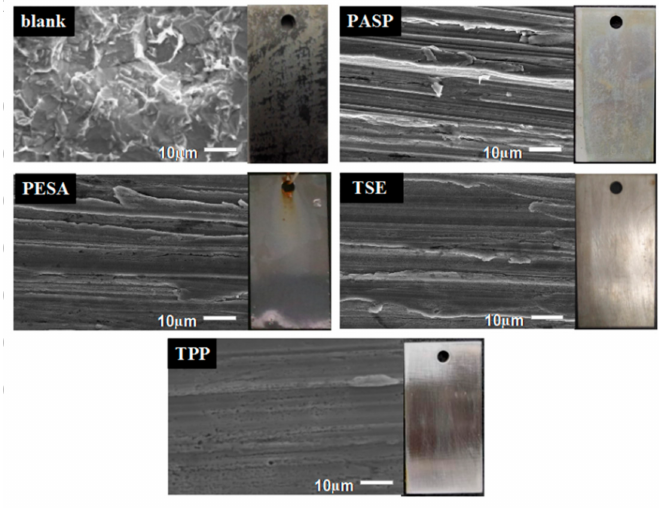
Figure 4. SEM morphologies and optical images of the carbon steel specimen immersed in blank, PASP, PESA, TSE, and composite inhibitor TPP at the concentration of 1000 mg /